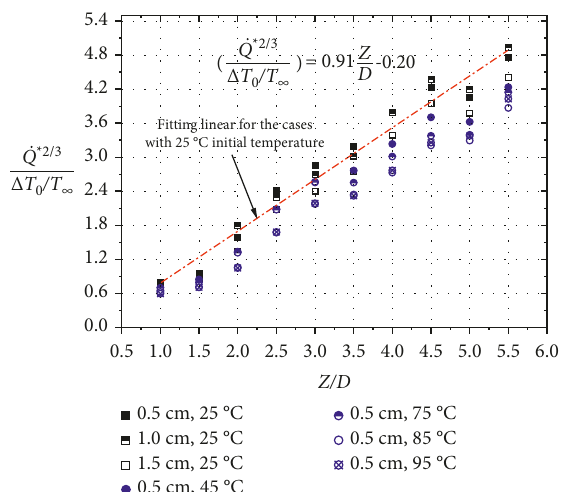
Figure 8: Dimensionless temperature profile of the fire plume as a function of normalized vertical height Z / D